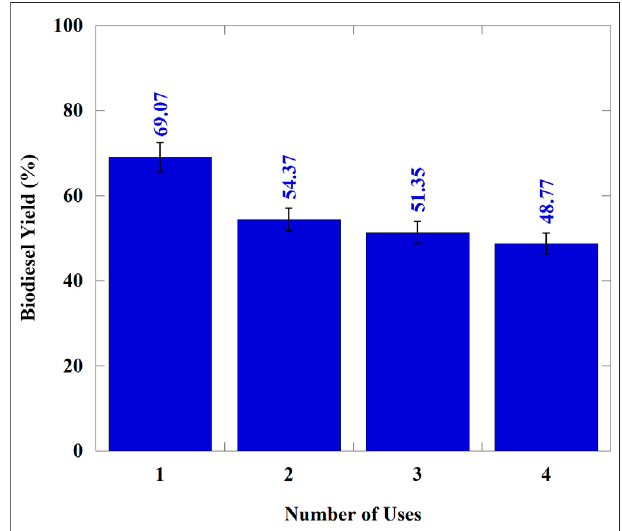
FIGURE 6 | Reusability test of biodiesel